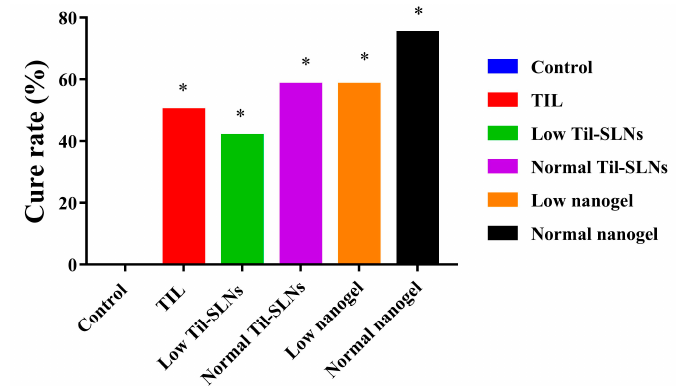
Figure 7. The cure rate of various groups after administration. Note: TIL: treatment with commercial